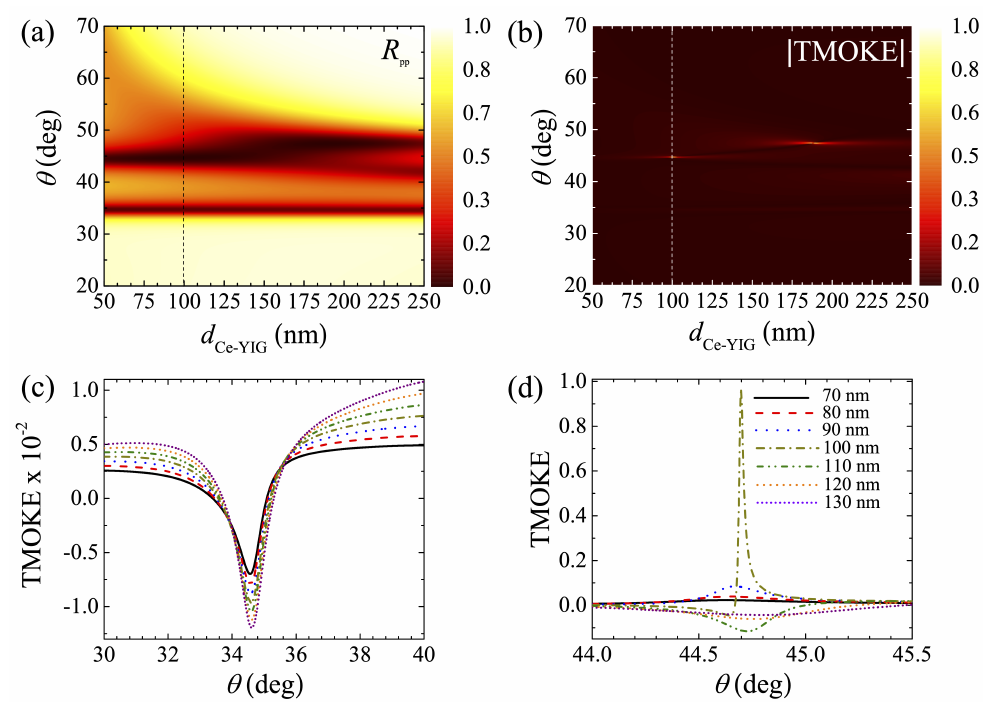
Figure 4. ( a ) Reflectance R pp for m = 0 (i.e., the demagnetized system) and ( b ) | TMOKE | as functions of the incident angle ( θ ) and the MO layer thickness ( d Ce − YIG ). TMOKE associated with the ( c ) BPP 0 (34.71 ◦ ) and ( d ) BPP 1 (44.69 ◦ ) resonances for different d Ce − YIG values. All the calculations in this figure were performed using d m = 20.42 nm and d Ce − YIG = 100 nm.